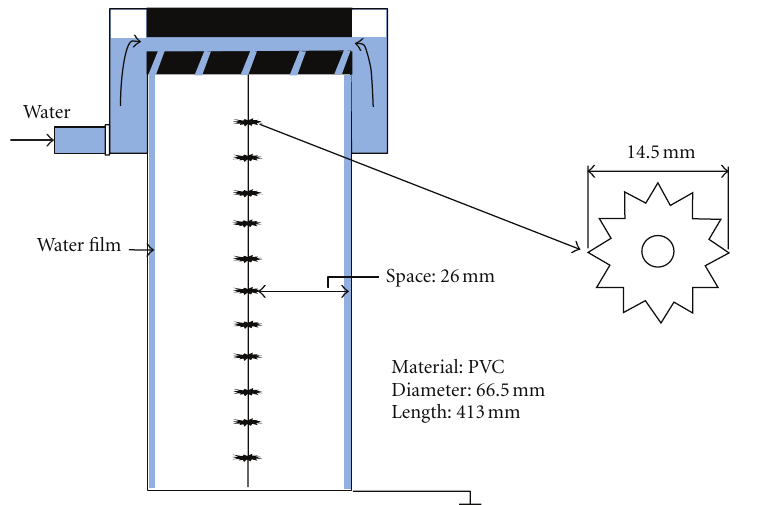
Figure 2: Schematic diagram a modified wet ESP.